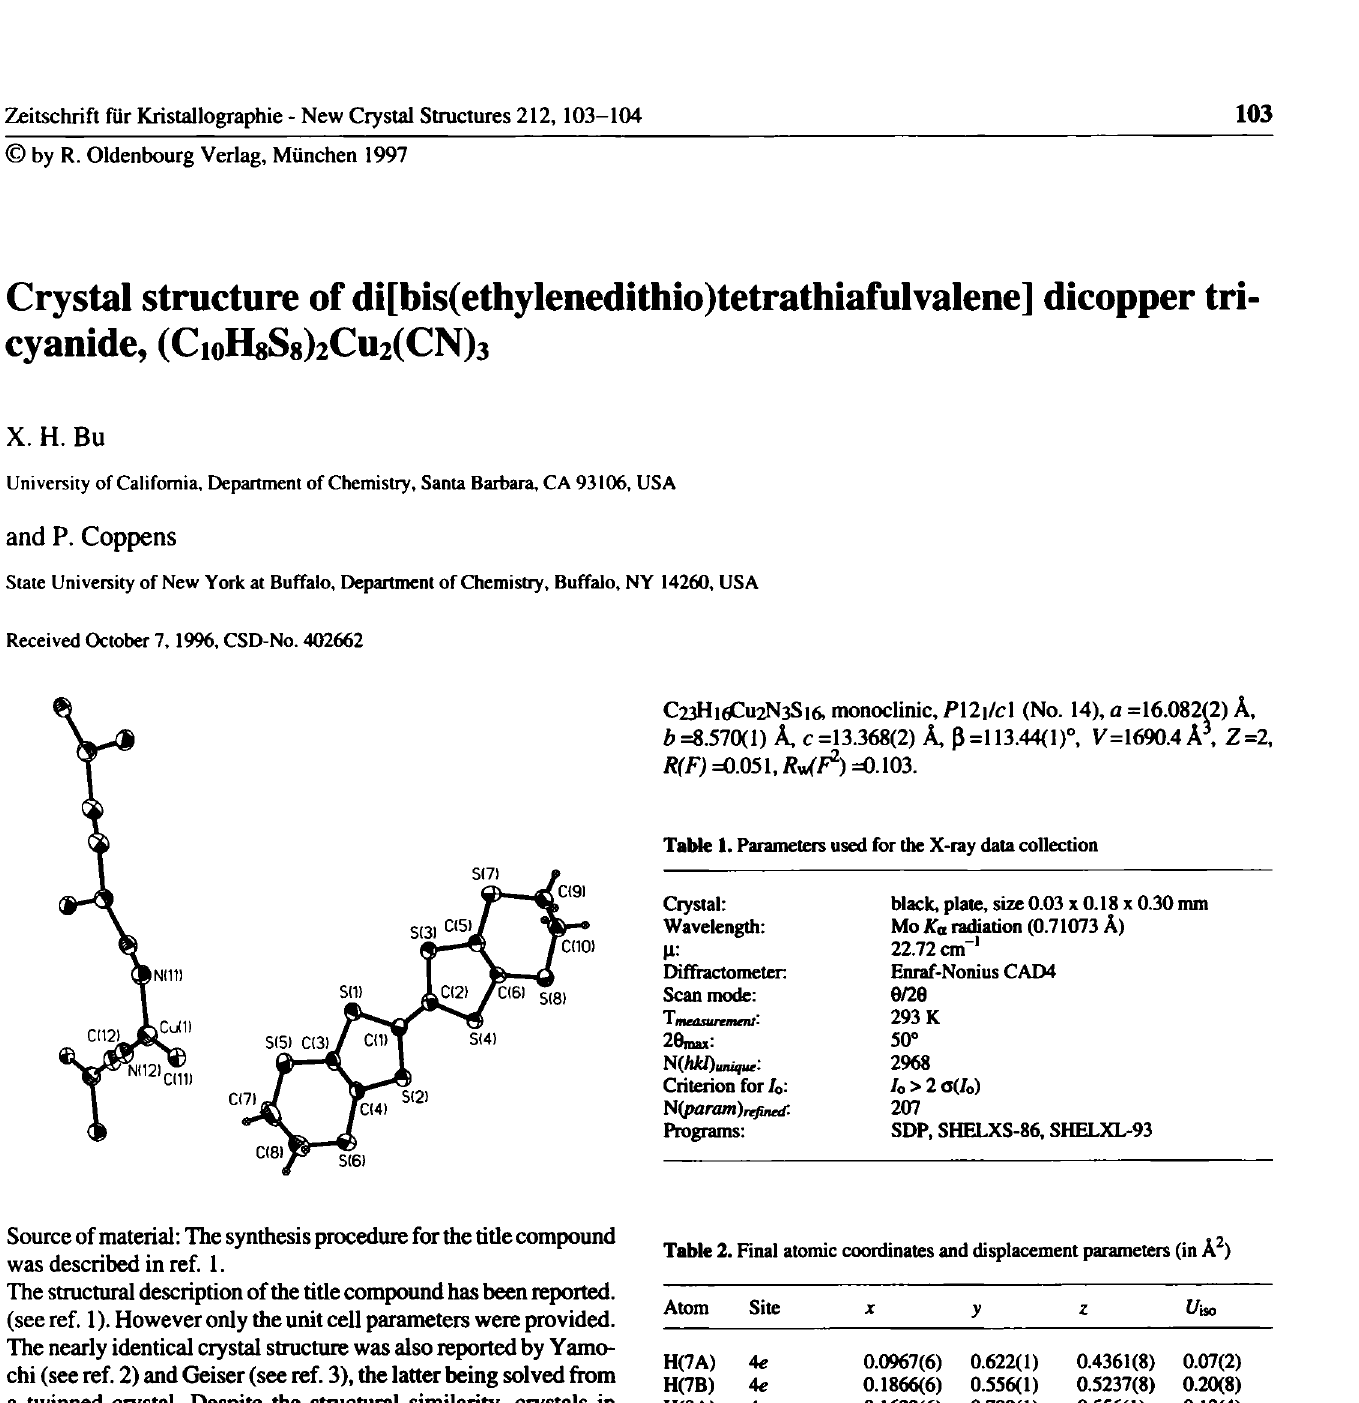
Table 2. Final atomic coordinates and displacement parameters (in A 2